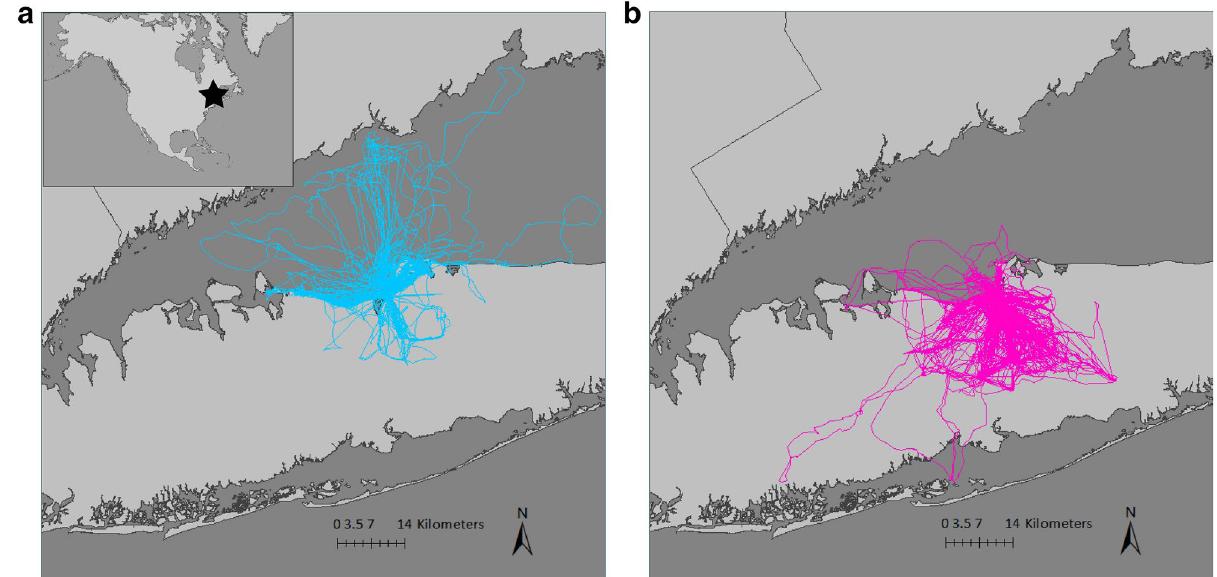
Figure 1. ( a ) GPS tracks of gulls from our study site showing great black-backed gulls (blue) traveling to open water and coastal areas on foraging trips and ( b ) herring gulls (pink) traveling toward urban habitats on foraging trips. The location of the study site on Long Island, NY in North America is shown (star symbol, inset). Maps produced using ArcGIS (v. 10.8.1). HERG GBBG